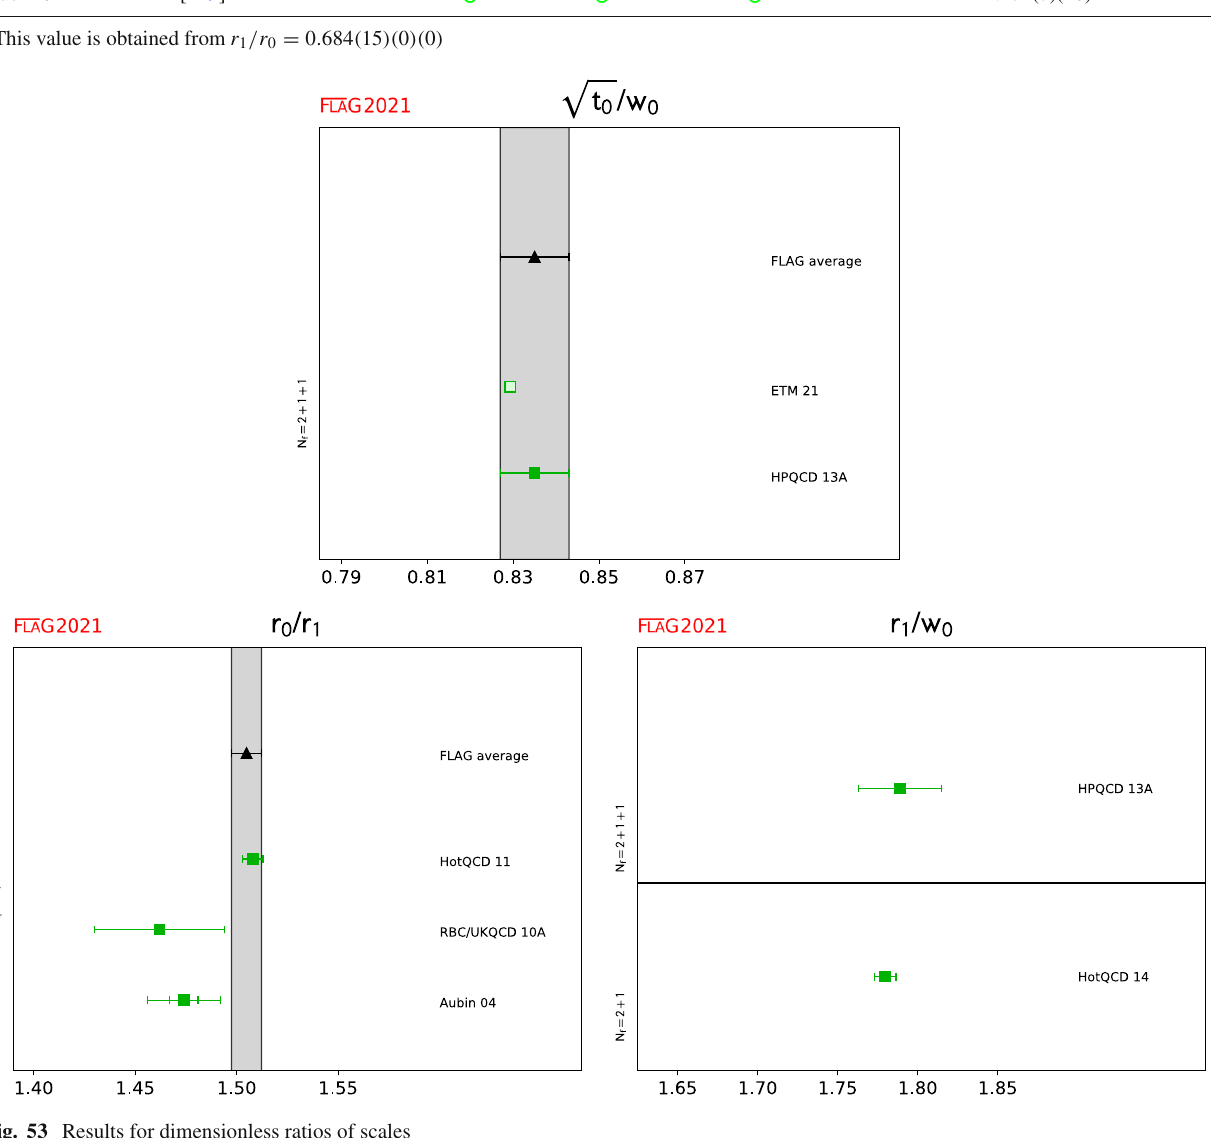
Fig. 53 Results for dimensionless ratios of